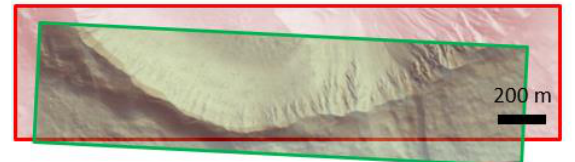
Figure 6 Overlapped images of the Hershel Crater Test.